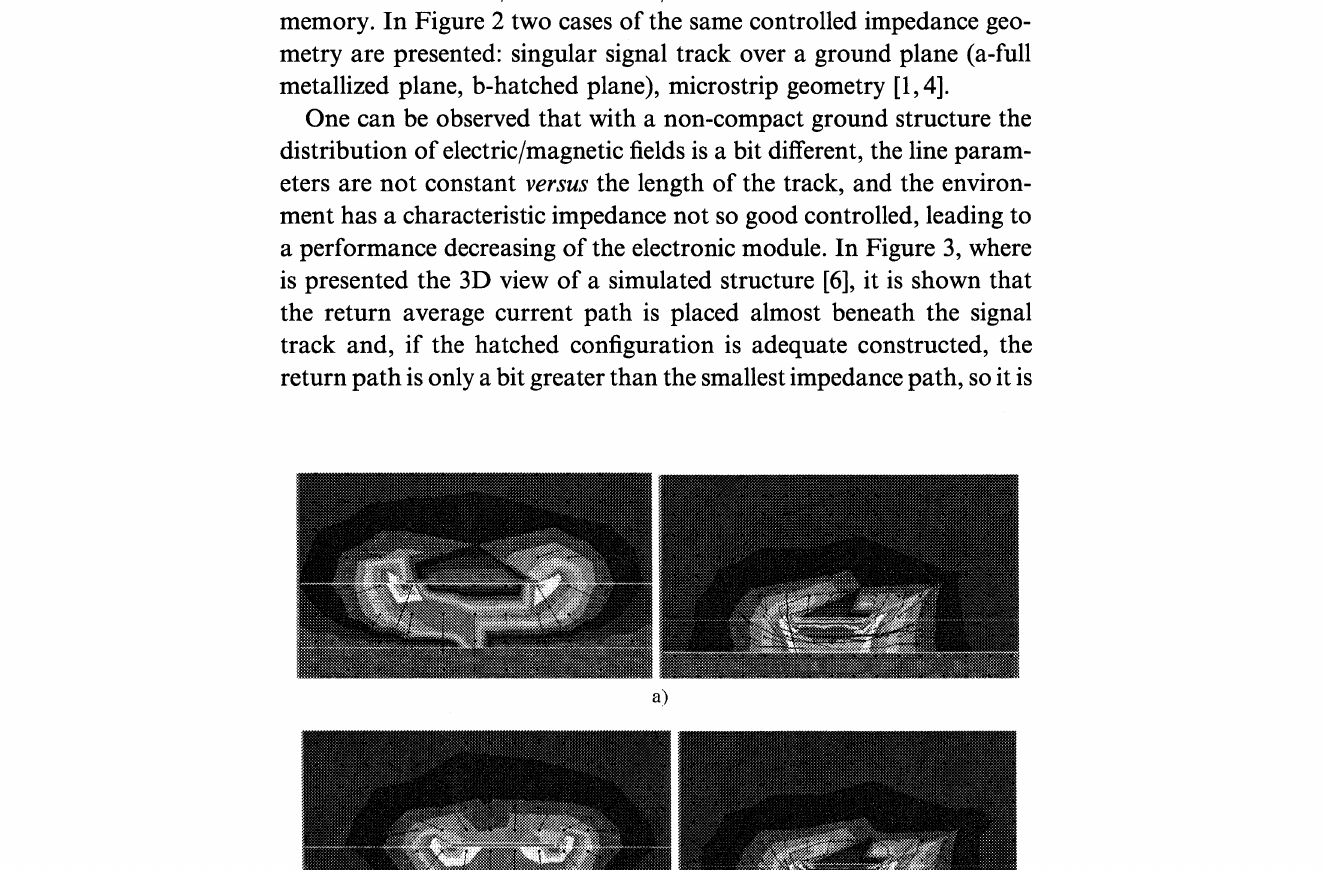
FIGURE 2 Simulation of interconnection geometries with compact/hatched ground